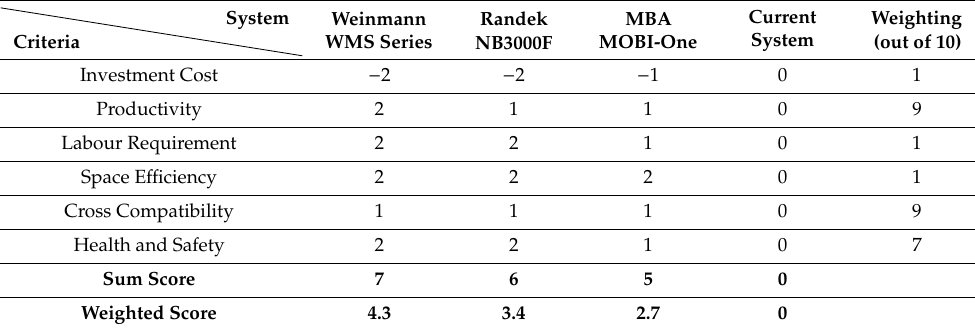
Table 5. Resultant scores for multifunctional